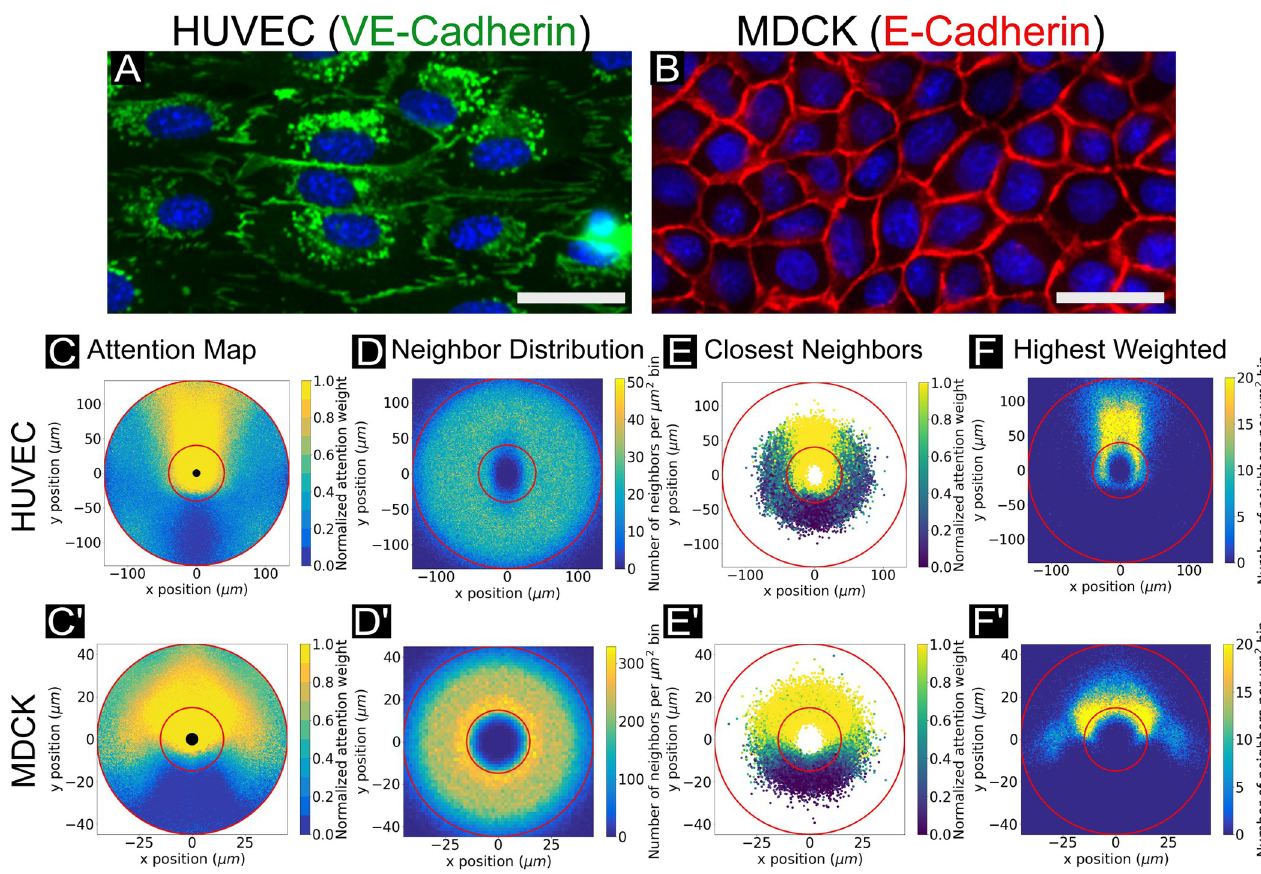
Fig 2. Network attention across canonical cell types. (A) VE-cadherin cell-cell junctions are indicated in red, with cell nuclei indicated in blue. VE-cadherin fingers in HUVEC cells indicate the direction of coupling between leader and follower cells. Scale bar is 30 μ m. (B) E-cadherin cell-cell junctions are indicated in red, with cell nuclei indicated in blue. E-cadherin walls do not visibly indicate coordination as VE-cadherin in HUVECs. Scale bar is 30 μ m. (C, C’) Representative attention weight contour plots are shown for HUVEC ( top ) and MDCK cells ( bottom ). For all conditions, normalized weight maps are shown. The HUVEC attention map highlights the tendency of HUVECs to “follow the leader”, with high attention weight values assigned to cells directly in front of the focal cell, spatially. By contrast, the MDCK map displays higher attention weights forward and to the sides. Central black circles indicate the radius of the closest neighbor location in the dataset. For all plots shown, networks were structured to encompass 10 neighbors, with trajectory timesteps of 10 minutes and forward prediction times of 20 minutes. (D, D’) Histograms showing the distribution of data points (neighbor cell locations) from which the attention maps in (C, C’) were generated. In (C, C’) and D, D’), thin red circular lines indicate the annulus in which the bulk of the data (5%-95%) lies by radius (see Methods ). Network results are expected to be more reliable within this region. Histogram bins span 1 μ m 2 . (E, E’) Scatter plots showing locations of the closest neighbor to a focal agent across all focal cells, colored by normalized attention weight. (F, F’) Histograms showing the locations of only the neighbor with highest weight value for each individual focal cell. Histogram bins span 1 μ m 2 .